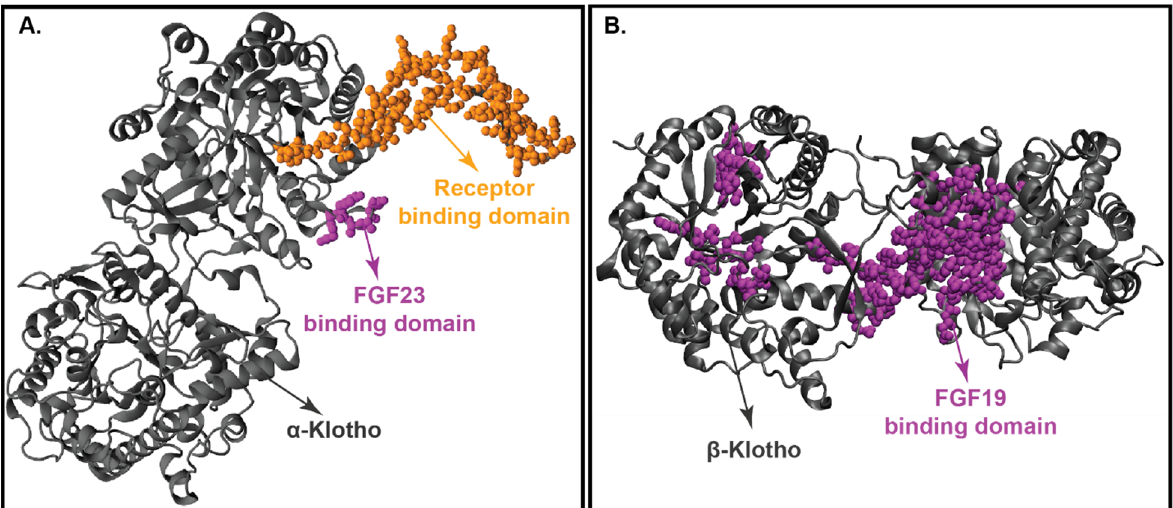
Figure 5. Crystal structure of klotho proteins. Panel- A: Crystal structure of KLA. Panel- B : Crystal structure of KLB. Both KLA and KLB’s backbone is represented in grey, protein binding domain (FGF23 for KLA and FGF19 for KLB) shown in magenta, and receptor binding domain is represented in yellow.